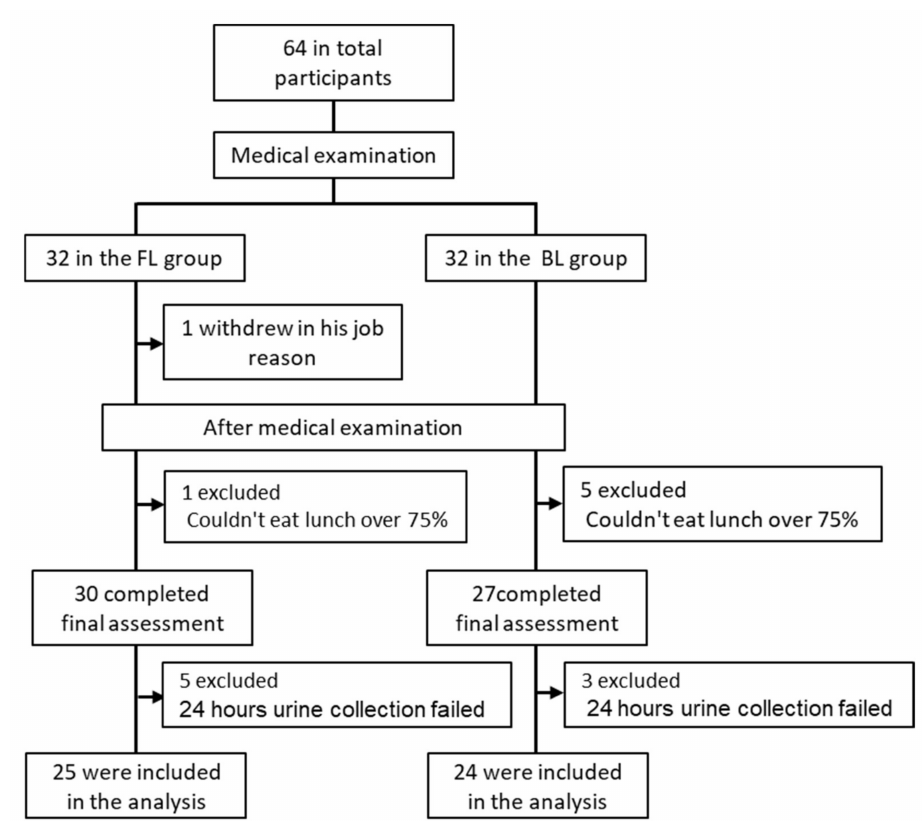
Figure 1. Enrollment of the participants and completion of the study. FL: Fortified Lunch group and BL: Balanced Lunch group.